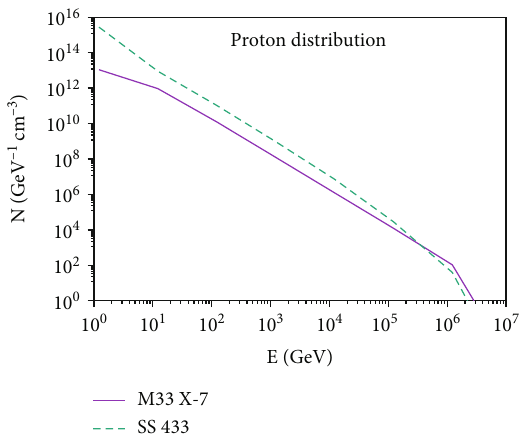
Figure 4: Proton energy distribution for M33 X-7 and SS 433 microquasar